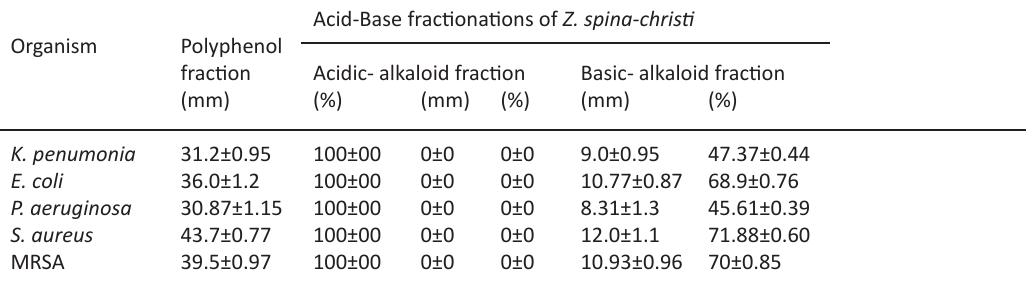
Table 2. Antibacterial activity of Acid-Base fractionations of Z. spina-christi against MDR-bacterial isolates Acid-Base fractionations of Z.